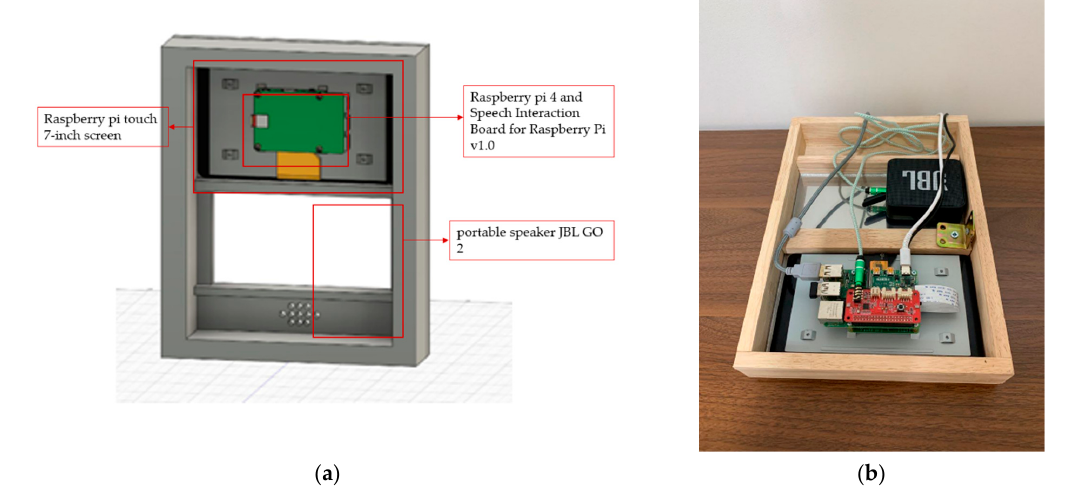
Figure 7. LUX hardware: ( a ) hardware as a half-mirror shape; ( b ) back view of the LUX.